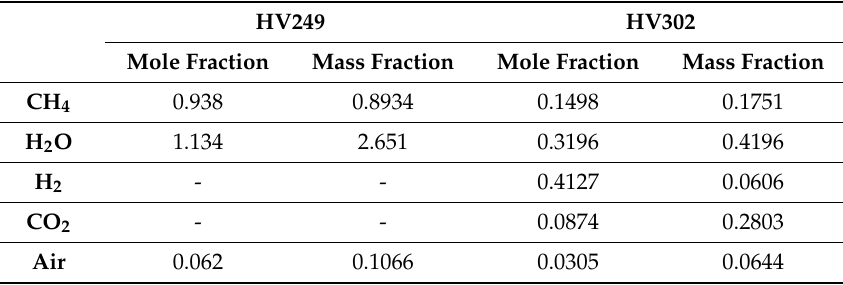
Figure 4. Leaked valve positions in the MCFC stack package. Table 2. Leaked gas Table 1. Heat flux of the heating area of the stack package model.